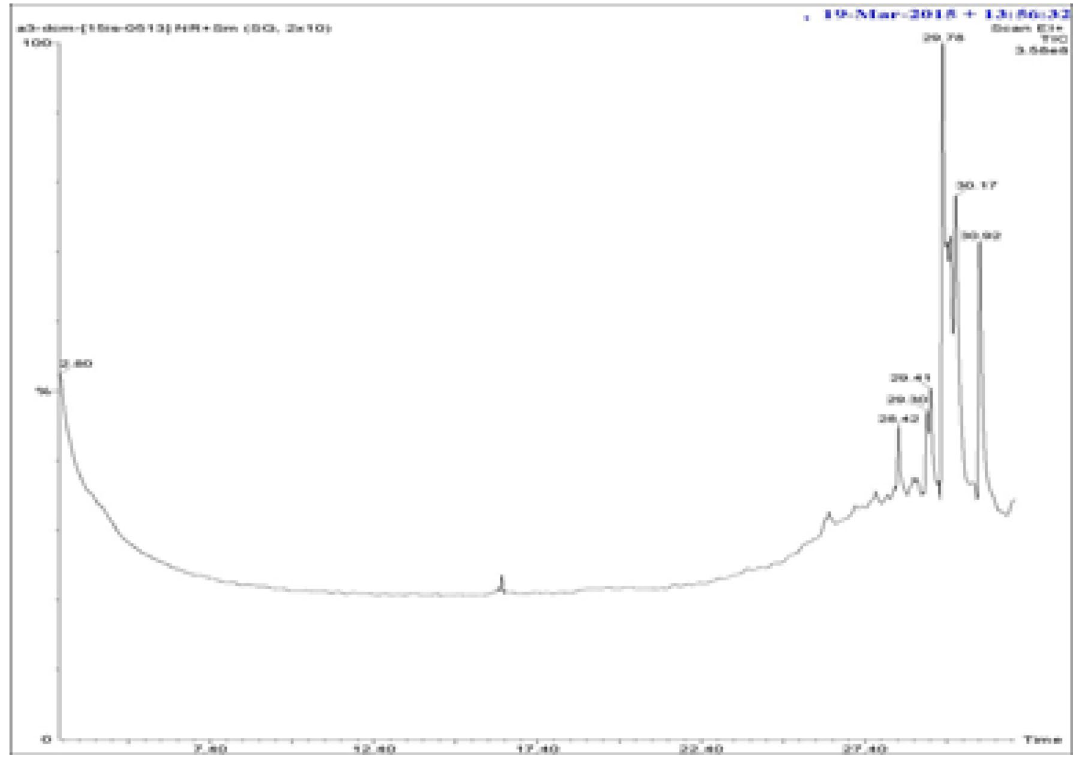
Fig. 1 GCMS chromatogram of F1